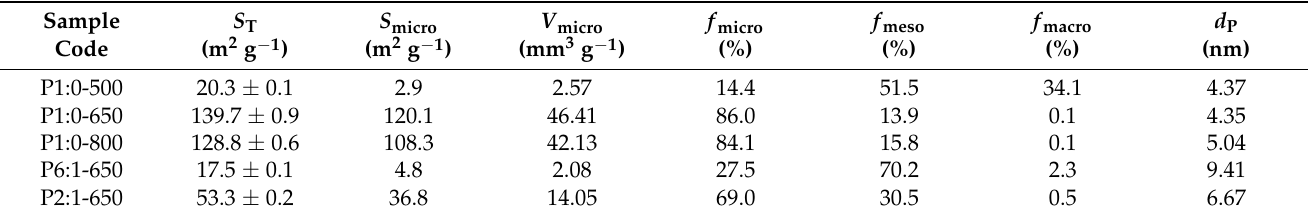
Table 2. Specific surface area (S T ), specific micropore surface area (S micro ), specific micropore volume (V micro ) and average pore size (d P ) estimated by BET analysis. The fractions of micro-, meso- and macro-pores are also reported (f micro , f meso and f macro , respectively).